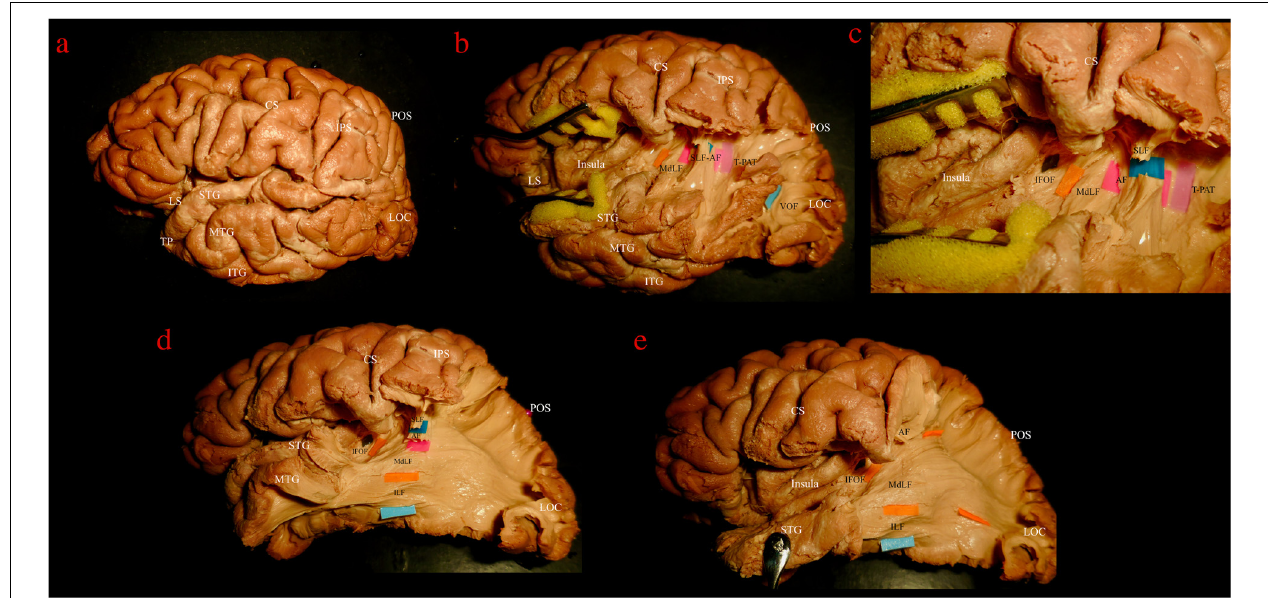
FIGURE 2 | Left hemisphere, lateral view. Stepwise dissection from lateral to medial structures. (a) Intact hemisphere. Relevant gyri and sulci for present dissection and orientation are tagged: central and lateral sulci (CS, LS); temporal pole (TP) and superior, middle and inferior temporal gyri (STG, MTG, and ITG); intraparietal sulcus (IPS); parieto-occipital sulcus (POS); lateral occipital cortex (LOC). (b) Dissection of temporo-parietal-occipital junction (TPOJ) area. From lateral to mesial, after removing U-fibers, different layers of associative bundles are encountered. Superficial layer: vertical component of superior longitudinal fascicle (vSLF, dark blue tag) and vertical occipital fascicle (VOF, light blue tag). Upper intermediate layer: arcuate fascicle (AF, magenta tag) and temporo-parietal aslant tract (T-PAT, pink tag). Lower intermediate layer: middle longitudinal fascicle (MdLF, orange tag). (c) Detailed view of the white matter layers at the deep TPOJ. vSLF has been interrupted to show the underling AF. Lower layer, formed by the inferior fronto-occipital fascicle (IFOF, black tag) is now shown as running more medial through the posterior sub-insular region and external capsule. (d) VOF, T-PAT and the inferior, temporal, aspect of vSLF-AF have been removed uncovering the inferior longitudinal fascicle (ILF, light blue tag), which runs inferior and parallel to the MdLF fibers within the SS and the temporal lobe. (e) The STG has been reflected and SLF and AF further removed in order to show the course of MdLF from STG to the parieto-occipital cortex.